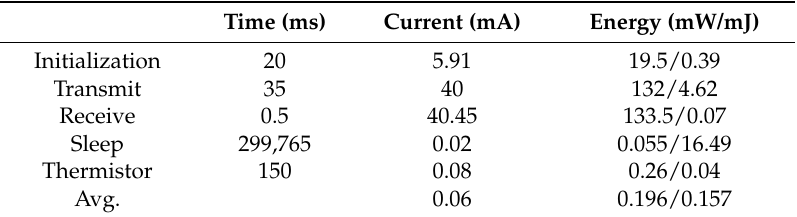
Table 7. Energy consumption of system operations and average estimation, assuming a measurement frequency of 0.0033 Hz.